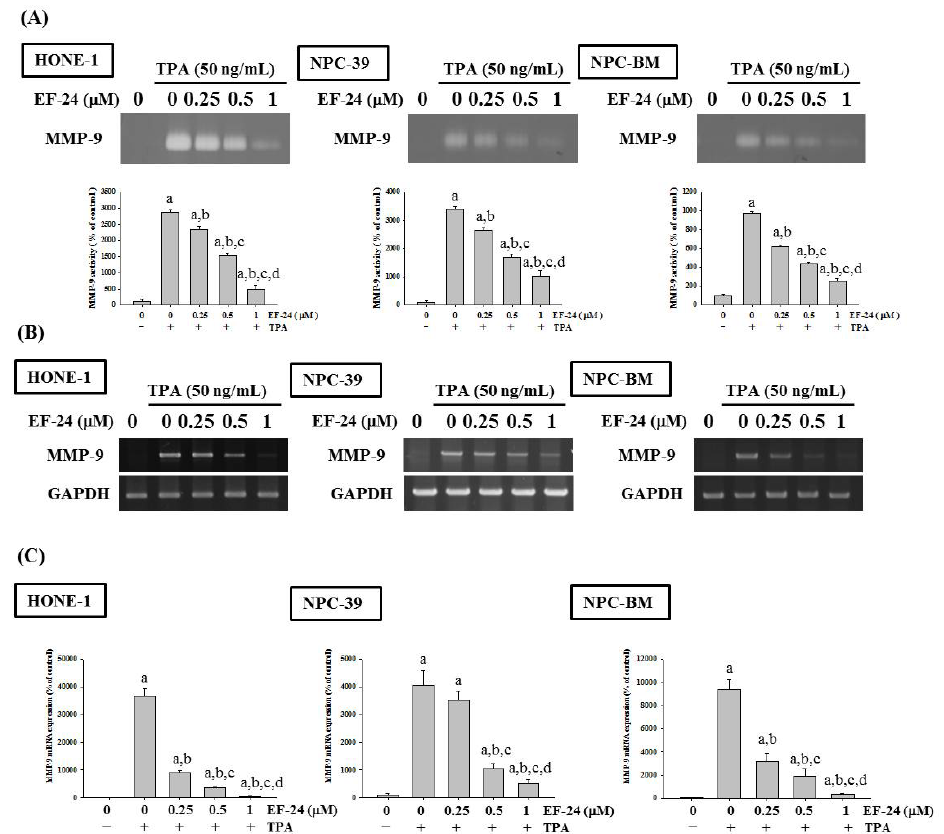
Figure 3. EF-24 suppresses the activity and expression of MMP-9 in NPC cells. HONE-1, NPC-39 and NPC-BM cells were pretreated with EF-24 for 1 h and incubated with TPA for an additional 23 h. Conditioned medium was collected for analyzing the activity of MMP-9 through gelatin zymography ( A ). Total RNA was extracted to assess the expression level of MMP-9 gene by using RT-PCR ( B ) and quantitative PCR ( C ). Densitometric analysis of gelatin zymography was conducted by the ImageJ software. The expression of the MMP-9 gene was normalized to the level of GAPDH gene. a Significantly different, p < 0.05, when compared with the control group. b Significantly different, p < 0.05, when compared with the TPA treatment group. c Significantly different, p < 0.05, when compared with the TPA treatment plus EF-24 (0.25 μM) group. d Significantly different, p < 0.05, when compared with the TPA treatment plus EF-24 (0.5 μM) group.